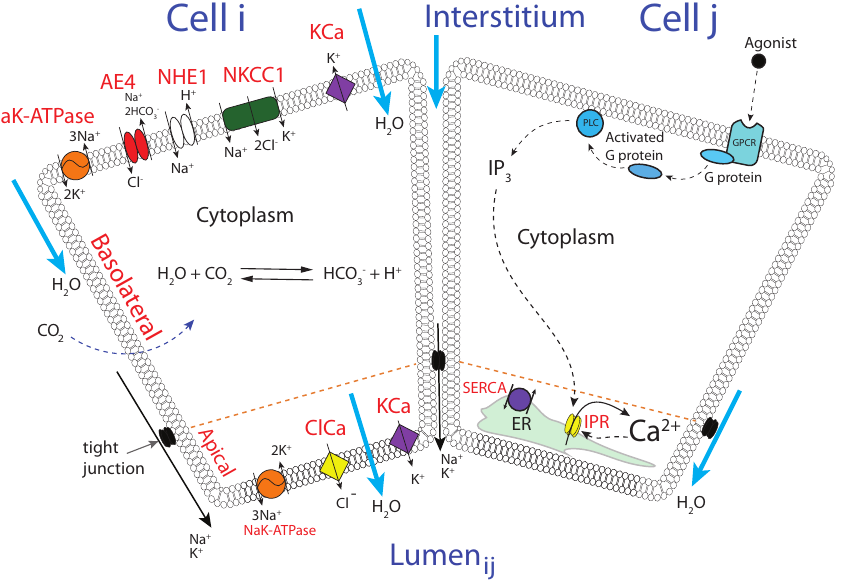
Figure 1. Schematic diagram of the processes underlying water transport by salivary gland acinar cells. Two identical cells are shown; cell i shows the relevant ion channels and transporters, while cell j shows the principal components of the Ca 2 + response. Although the two sets of processes are sepa- rated here for clarity, all the processes are present in all salivary gland acinar cells. Abbreviations are PLC (phospholipase C); IP 3 (inositol trisphosphate); IPR (IP 3 receptor); ER (endoplasmic reticulum); SERCA (sarcoplasmic/ER Ca 2 + ATPase); KCa (Ca 2 + -activated K + channel); ClCa (Ca 2 + -activated Cl − channel); NKCC1 (Na + /K + /Cl − cotransporter); NHE1 (Na + /H + exchanger); AE4 (anion ex- changer). We note that these channels and exchangers are not the only ones present in the cell but are the components that are believed to be the most important for the control of water transport in this cell type. Thus, other channels and exchangers (such as, for example, RyR or Na/Ca exchangers) that are known to be critical in other cell types are not included